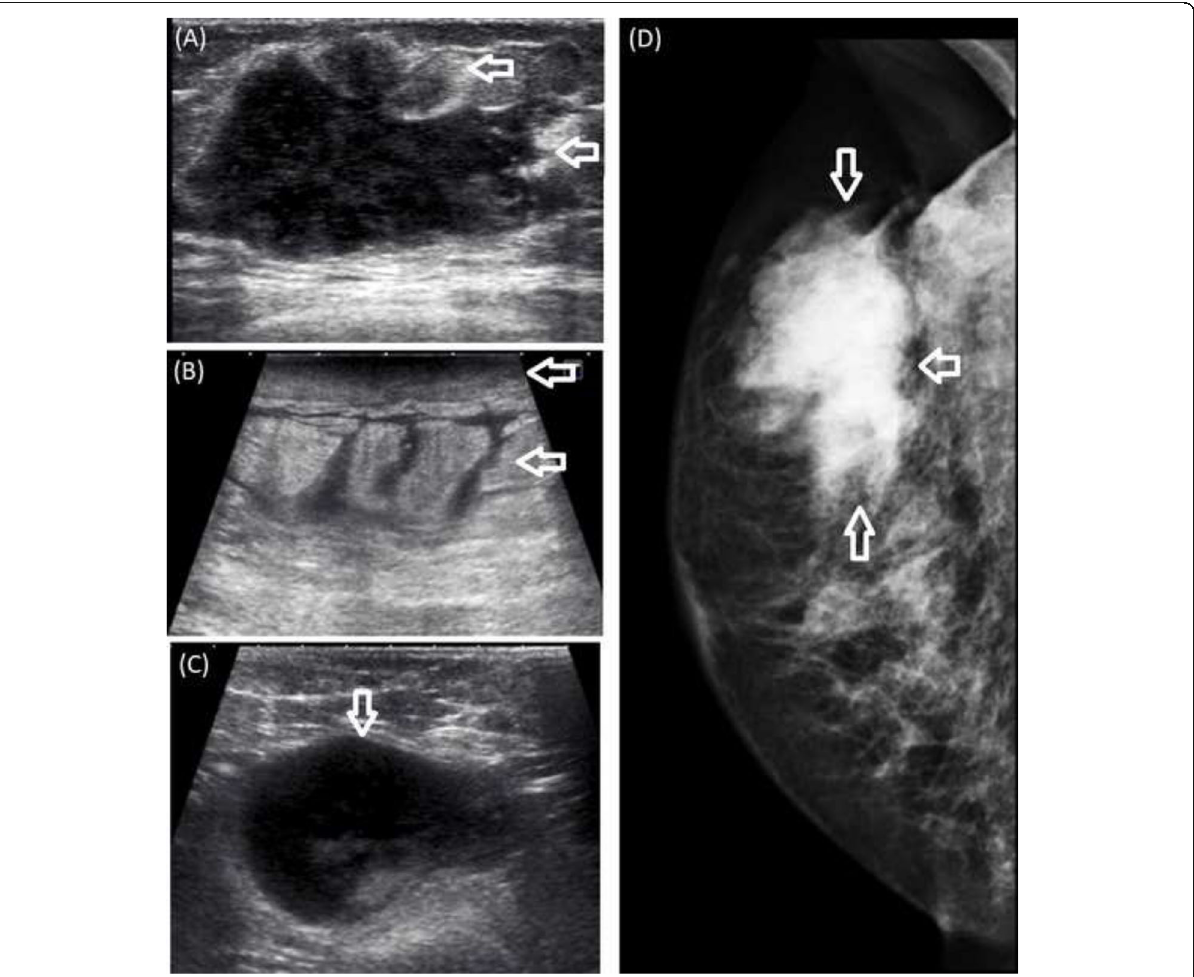
Fig. 2 Hematological malignancies mimicking malignant breast lesions. US ( a ) and mediolateral oblique image ( d ) of a patient diagnosed with lymphoma, showing an irregular-shaped, non-circumscribed lesion. Skin thickening and edema ( b ) and axillary lymphadenopathy ( c ) are seen on US images in another patient with